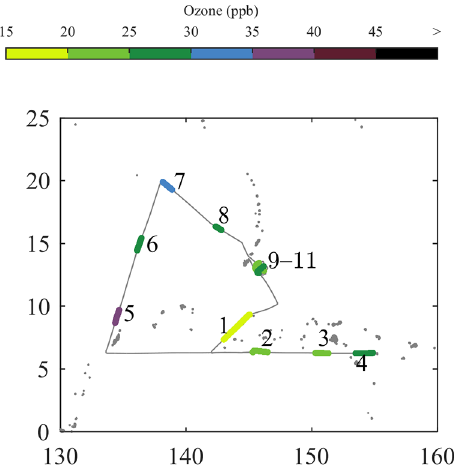
Figure 18. Flight track of RF04 with each profile coloured by mean tropospheric ozone as in Fig.